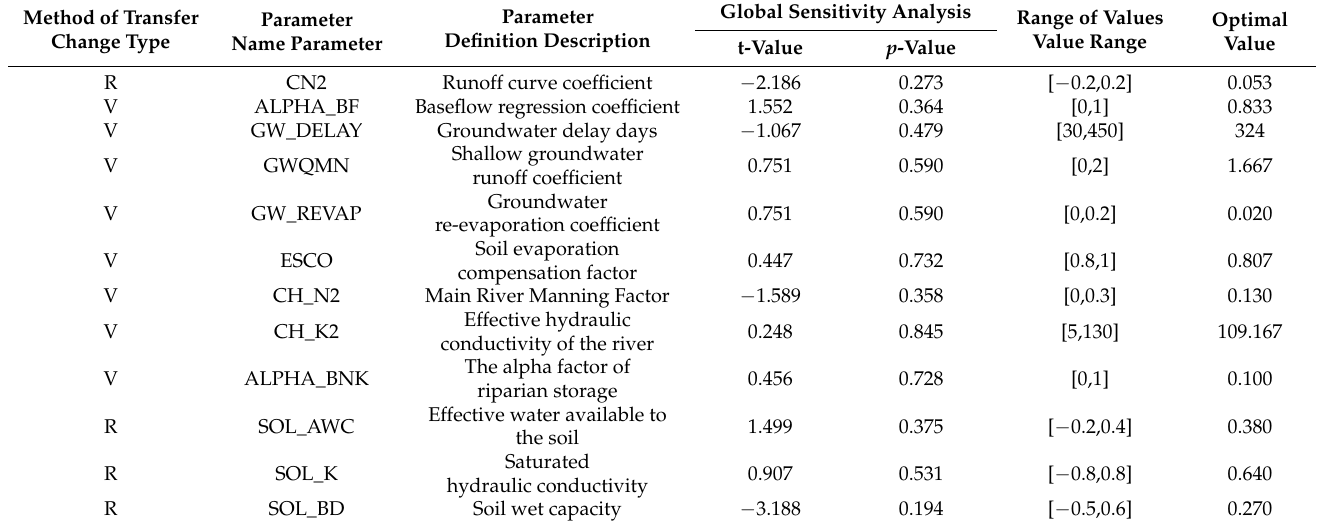
Table 2. Runoff sensitivity parameters.